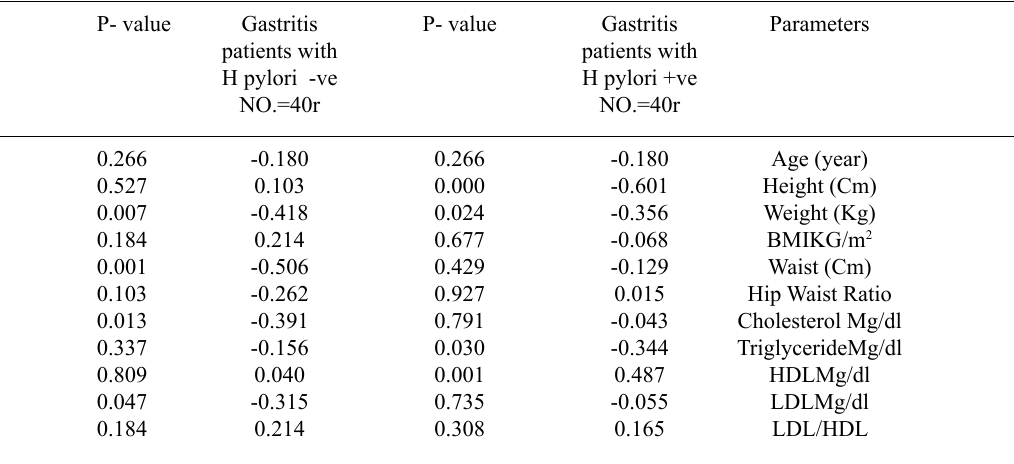
table 2. Pearson correlation analysis of adiponectin with different parameters in GERD